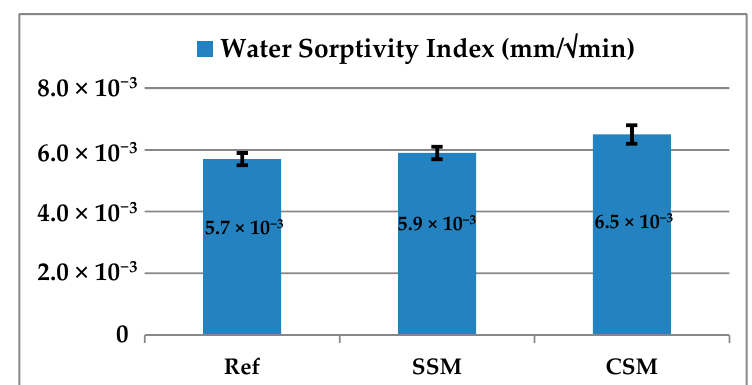
Figure 5. Water sorptivity of Ref. mix and rubber-cement mixtures (SSM and CSM) .